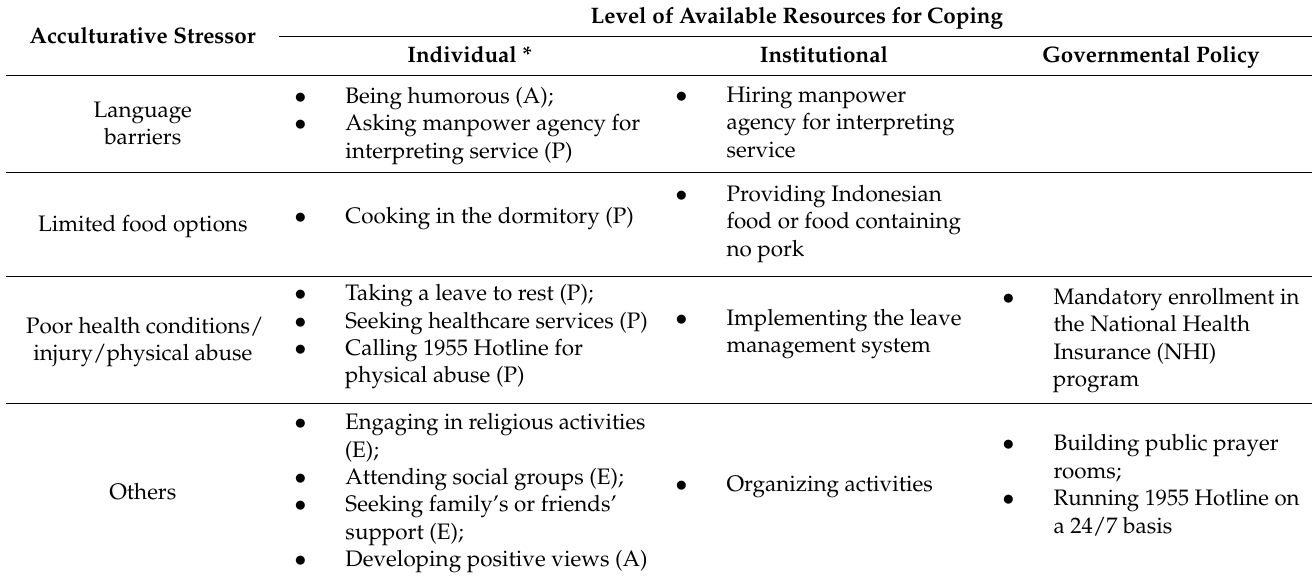
Table 2. Acculturative stressors and their coping